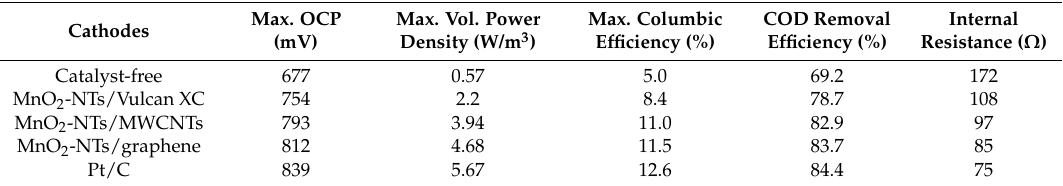
Table 3. Effect of the different carbon supports on the MnO 2 nanotubes (0.3 gm/cm 2 ) based air-cathode in the MFC and a comparison with the benchmark Pt/C [105].